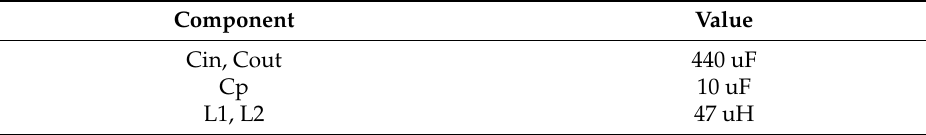
Figure 6. Linguistic variable E P (k). Table 2. Rules of inference. Rules P Figure 7. Output of the linguistic variable D(k).